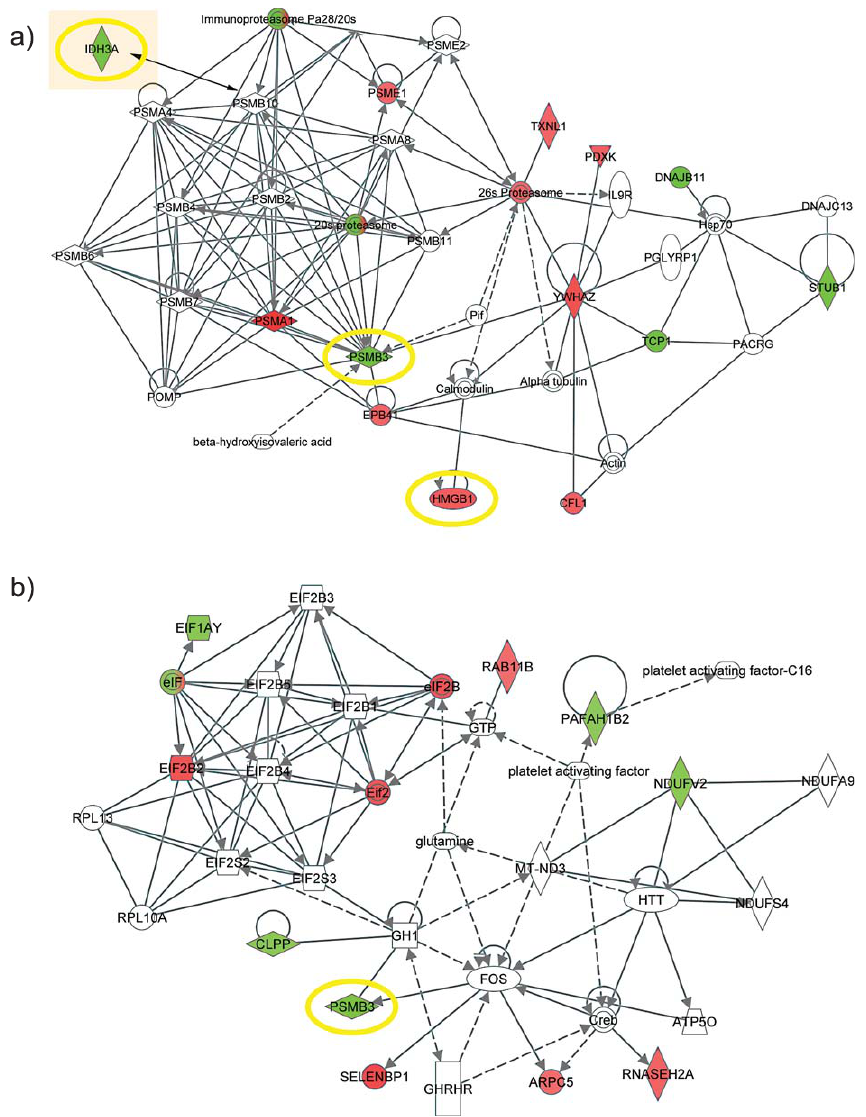
Fig.2. IPA-basedpathwayanalysisofdifferentialexpressedproteins.(a)IPAgenepathwayassociatedwith CellularAssemblyandOrganization containing PSMB3 and HMGB1 as significant regulated proteins in the DLD1+7 comparison. This network overlaps with network 2 (underlaid in orange) associated with Antigen Presentation containing IDH3A. Red and green designations indicate over- and under-expressed proteins in the respective groups. PSMB3, HMGB1, and IDH3A are highlighted in yellow. (b) IPA gene pathway associated with Developmental Disorder , Nucleic Acid Metabolism , and Genetic Disorder containing PSMB3 as a significant down- regulated gene and protein in the DLD1+13 comparison. Red and green designations indicate over- and under-expressed proteins in the respective groups. PSMB3 is highlighted in yellow. with Cellular Growth and Proliferation, Nucleic Acid Metabolism , and Small Molecule Biochemistry